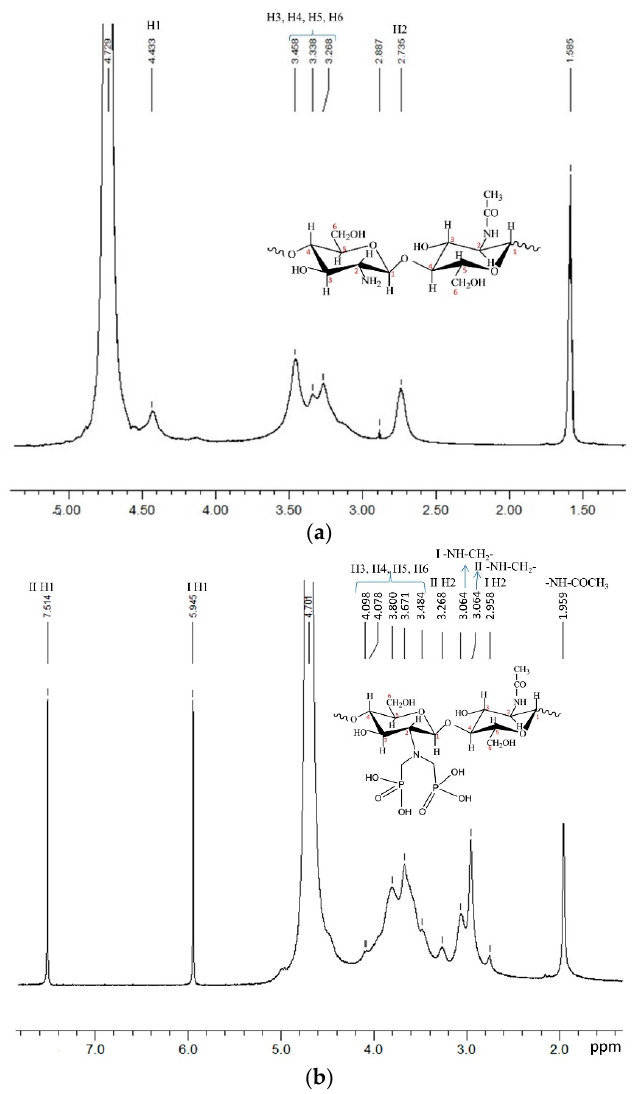
Figure 4. Nuclear magnetic resonance (NMR) spectra of ( a ) chitosan and ( b ) N -methylene phosphonic chitosan (NMPC).